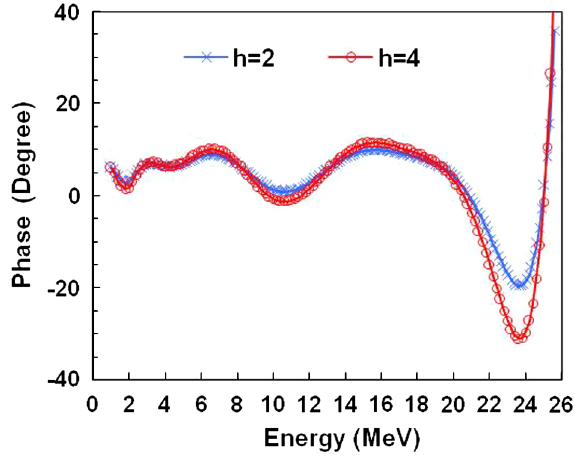
FIG. 11. Phase curves for the h ¼ 4 and h ¼ 2 modes of ¼ 50 kV . operation with V dee